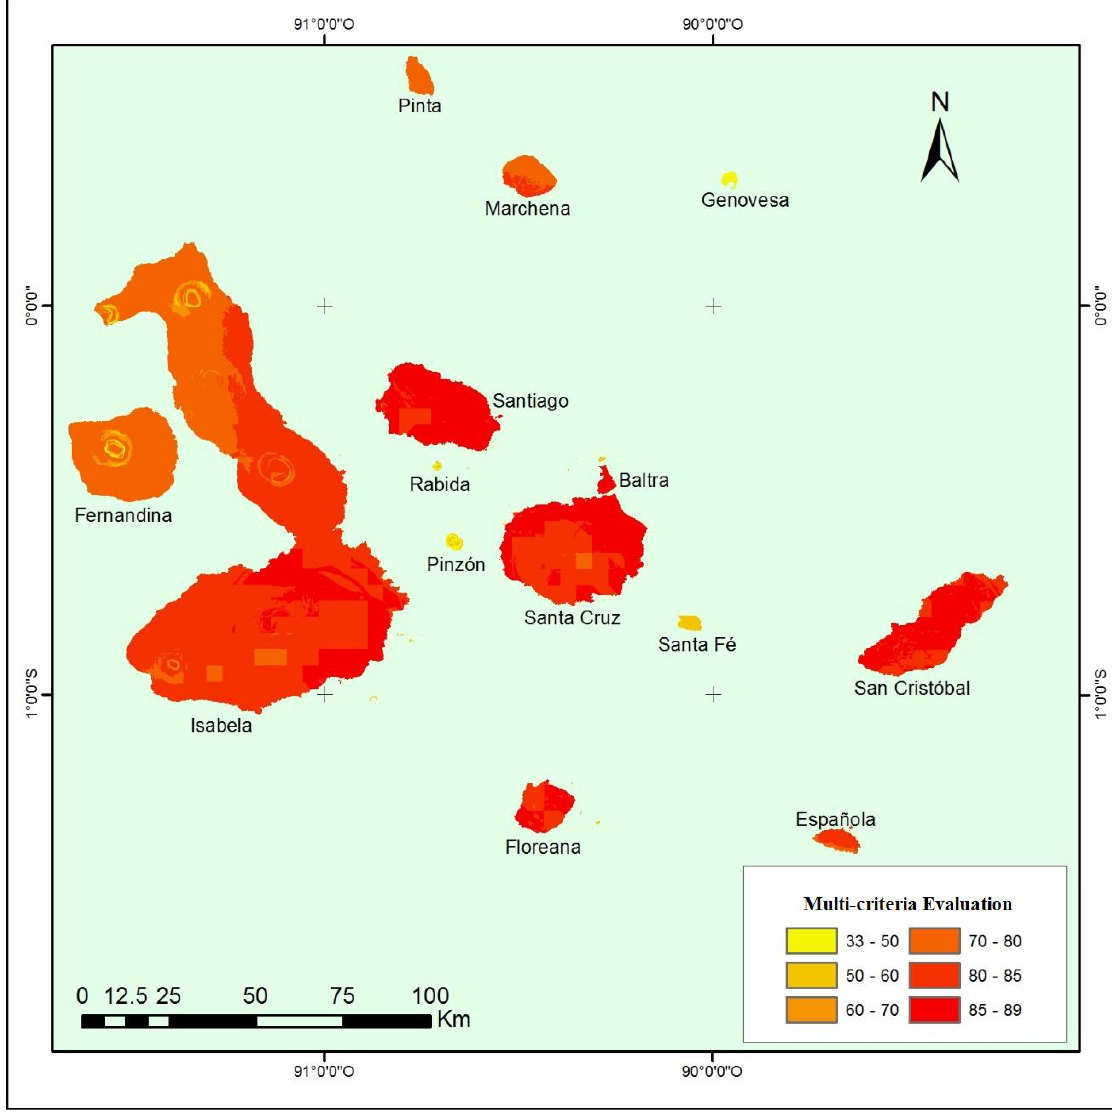
Figure 6. Multicriteria Evaluation for photovoltaic energy location.